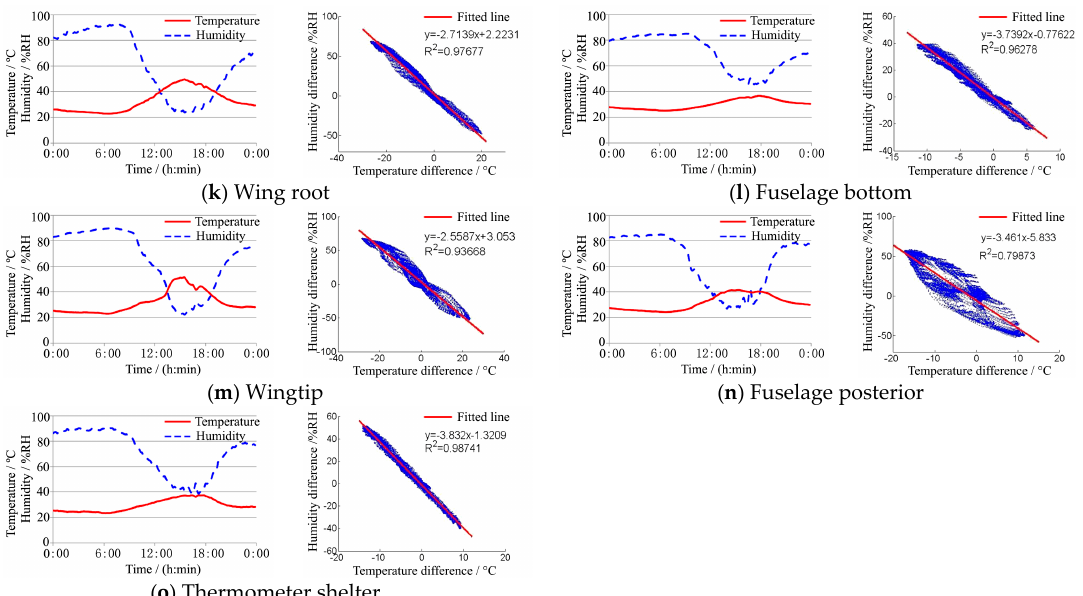
Figure 3. Curves of temperature-humidity relationship and rate of change of temperature and humidity of each bay.